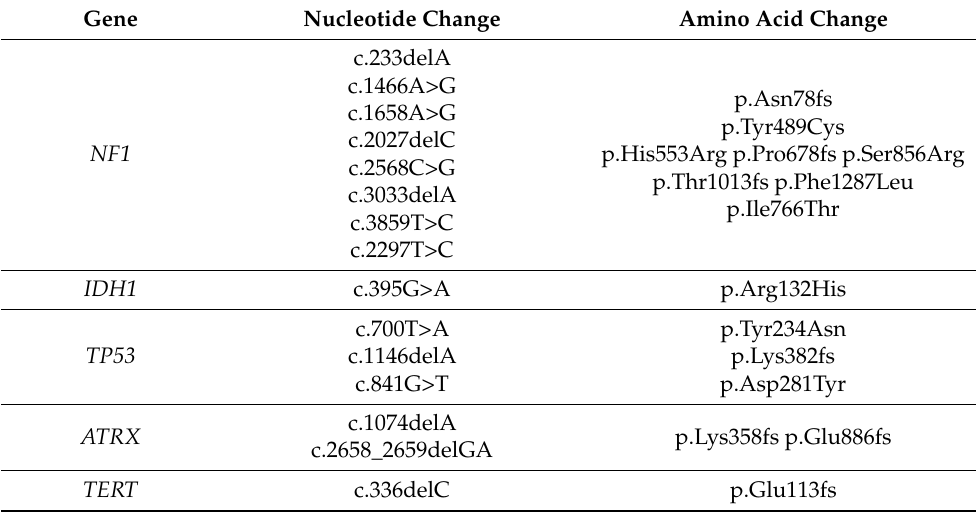
Table 4. Genomic variants with pathogenic significance found in blood-derived EV of the 10 patients with grade 4